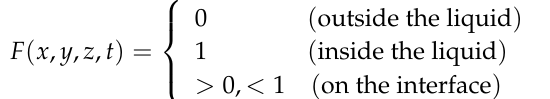
Figure 1. Distribution of active forces on the liquid cone-jet.